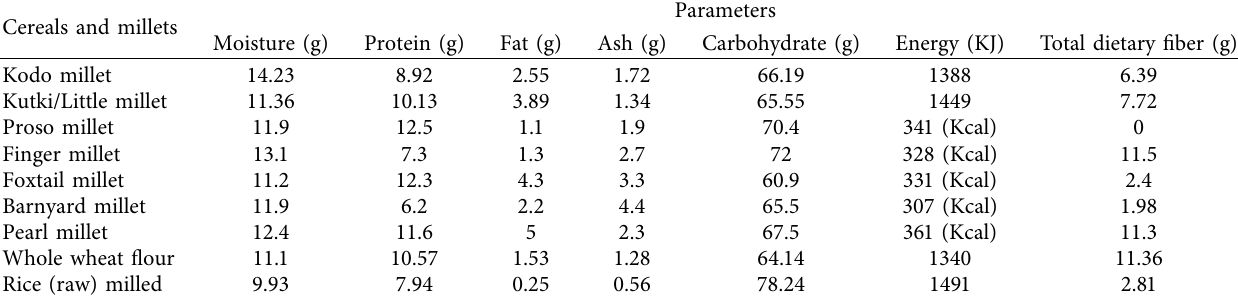
Table 1: Proximate composition of millets compared to cereals.